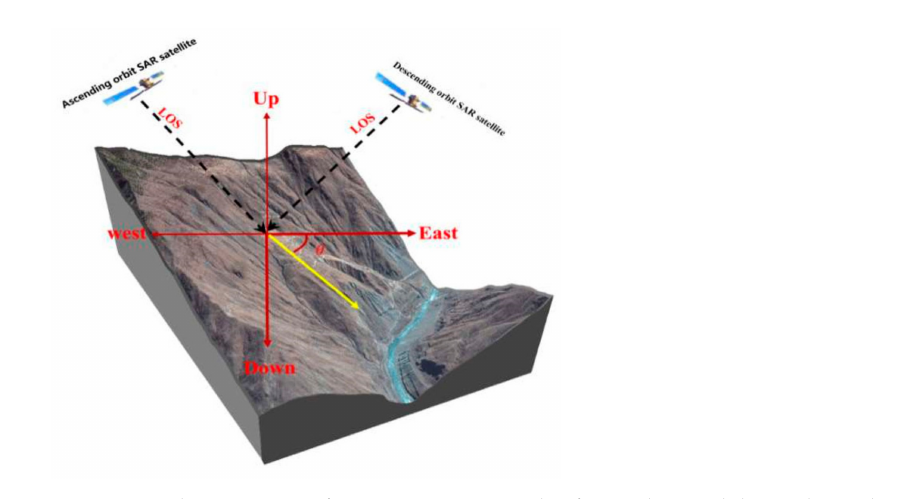
Figure 13. Sentinel-1 ascending orbit ( left ) and descending orbit ( right ) data visibility distribution map.